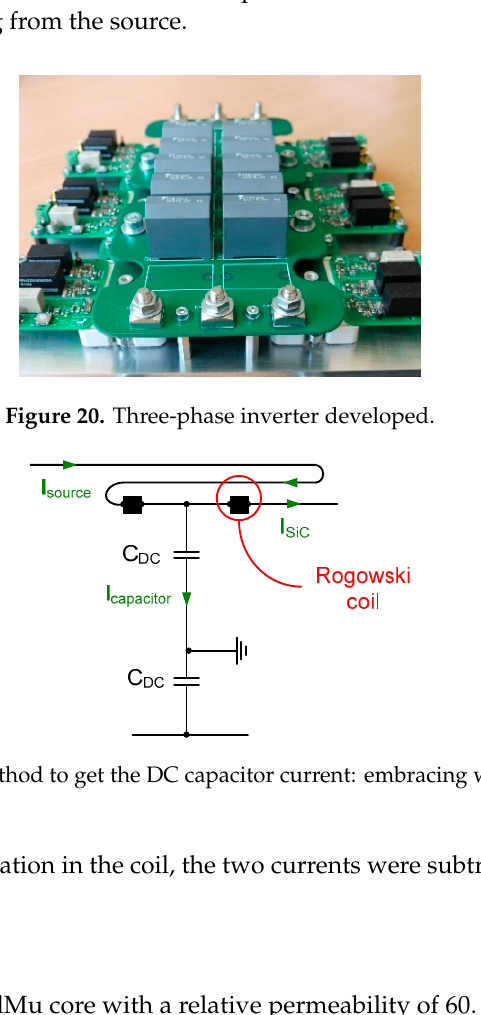
Table 4. Comparisons between optimization results and experiments for the powder core solution.